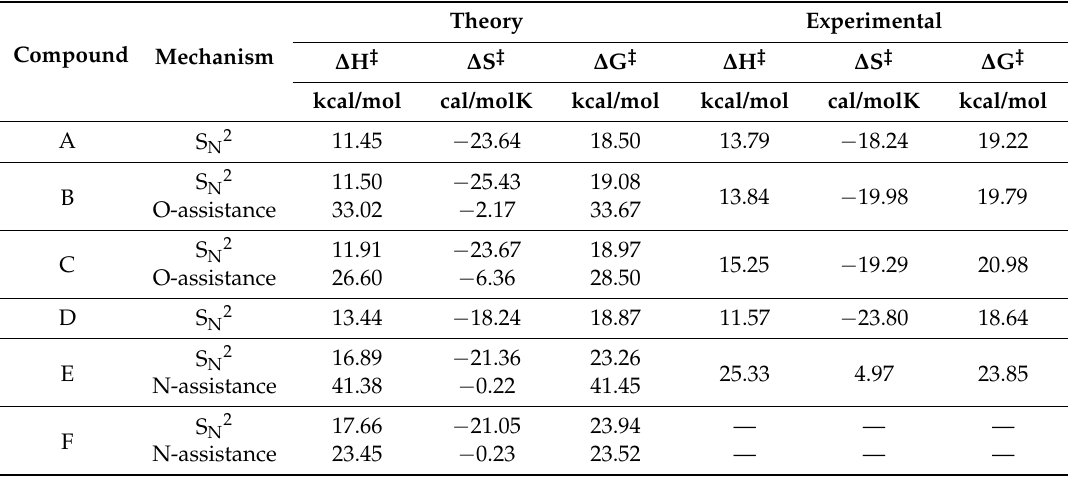
Table 1. Thermodynamic properties at the wB97XD/6-311++g(2d,2p) level at 298.15 K, compared to experimental results mentioned by Katrice et al.